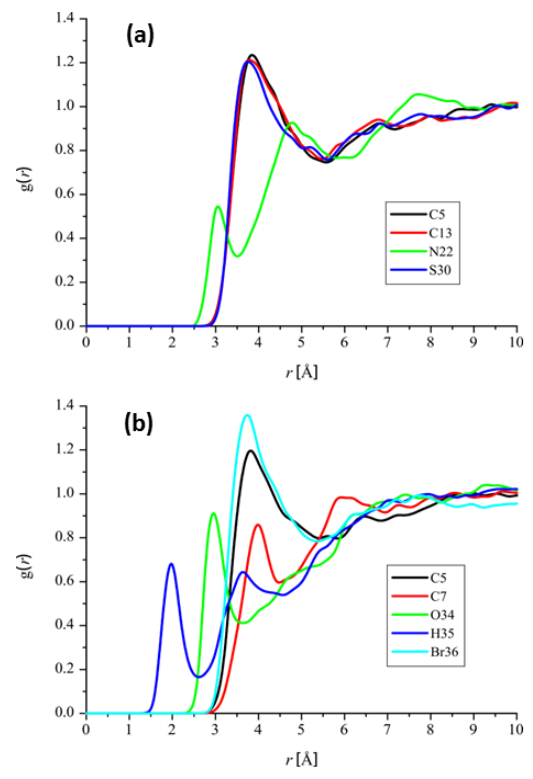
Figure 5. The most important RDFs of ( a ) PTM and ( b ) PIB.